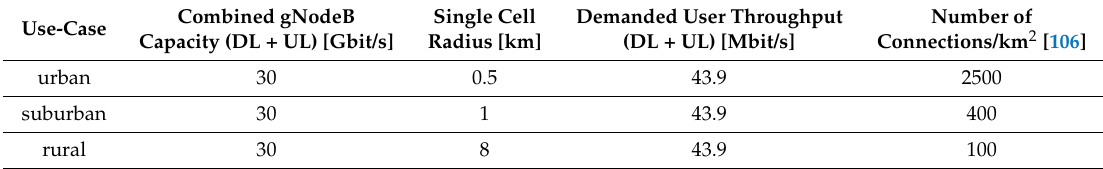
Table 5. Summarized list of parameters based on the deployment use-case.